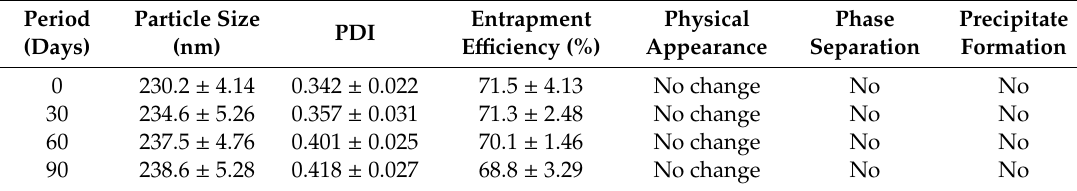
Table 5. Stability of ATZ-NLC for three months storage at 25 ± 2 ◦ C / 60% ± 5%